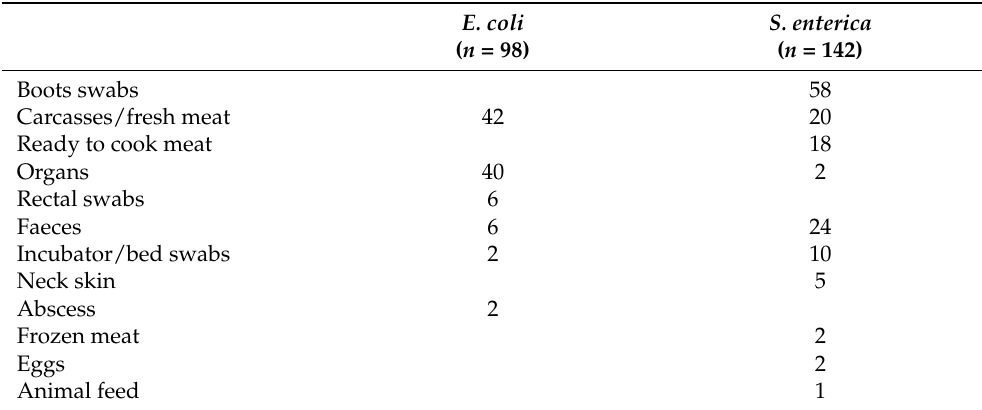
Table 2. Frequency of Escherichia coli and Salmonella enterica according to biological, food and environmental